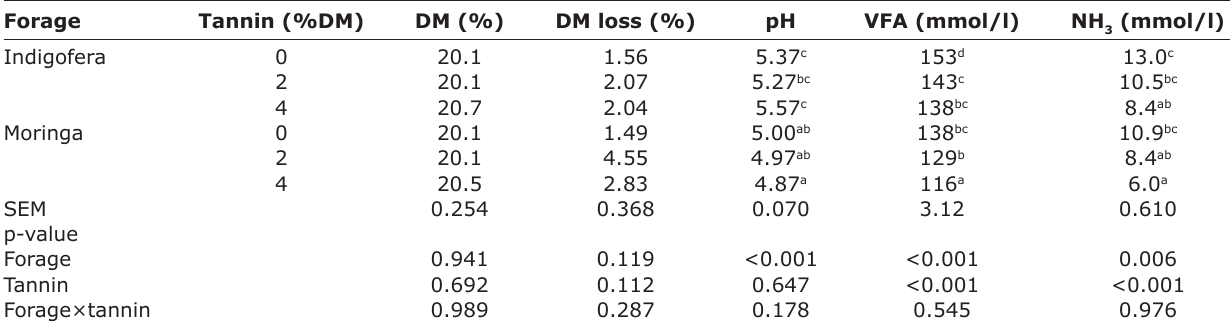
Table-2: Fermentation characteristics of Indigofera and Moringa leaf silage with different level of chestnut tannin addition. Forage Tannin